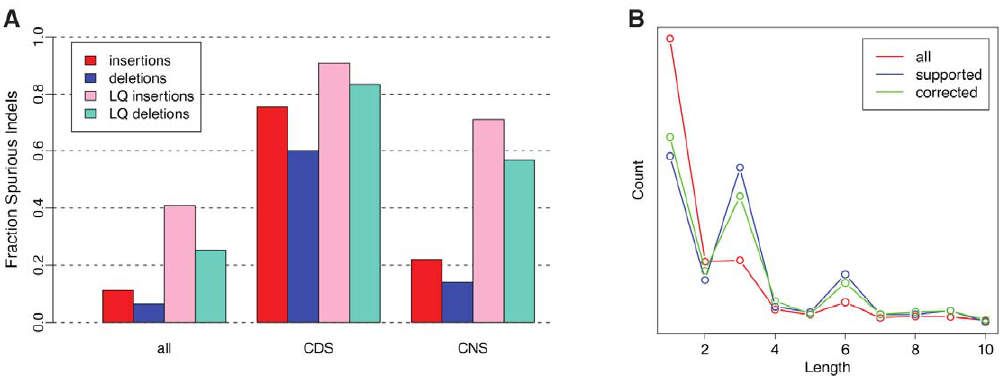
Figure 4. Error rates and length distributions for lineage-specific indels. (A) Fractions of apparent lineage-specific indels that are spurious, as estimated from ENCODE/2 6 alignments. Shown are median values over all 2 6 species after the polymorphism correction, for all sites and for only those sites within coding (CDS) or conserved noncoding (CNS) regions. Notice that insertions are substantially more likely than deletions to be spurious, because true deletions occur at higher rates than true insertions [29], while insertion and deletion error rates are comparable. LQ categories are the subset of indels with low quality ( , 25). (B) Distribution of indel lengths in coding regions for mouse lemur as compared to human, using dog as an outgroup. The red line (all) represents all indels inferred from the 2 6 assemblies, while the blue lines (supported) represents a subset of indels that could be validated by comparison with the ENCODE mouse lemur sequence. The green line (corrected) shows the distribution for the 2 6 assembly after automatic sequencing error mitigation (SEM) was applied using a quality score threshold of , 25. Notice that the pronounced period- of-three pattern in the supported indels is nearly lost in the unprocessed data due to sequencing error, but is mostly recovered by the SEM procedure. The effect is similar for the other 2 6 assemblies.